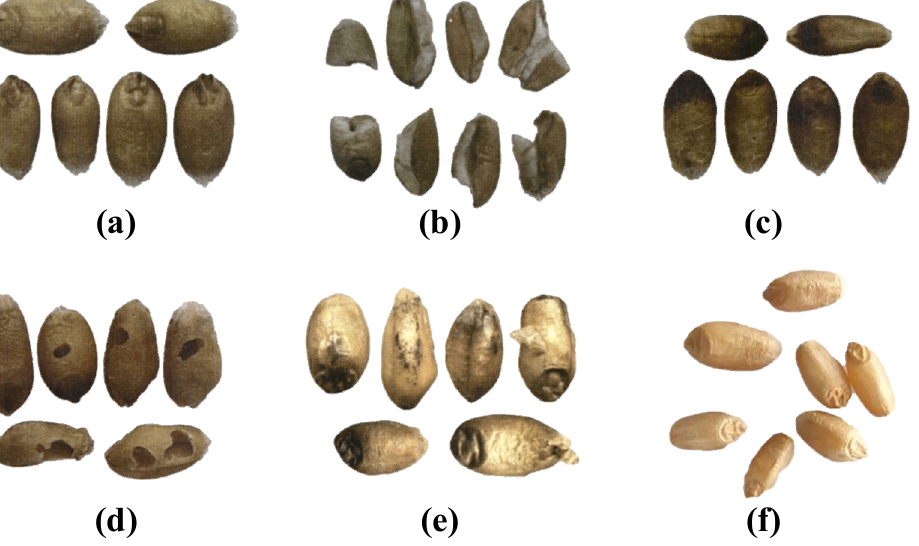
Figure 2. Appearance of unsound kernels and perfect kernels. ( a ) Sprouted kernels; ( b ) broken kernels; ( c ) spotted kernels; ( d ) injured kernels; ( e ) moldy kernels; ( f ) perfect kernels.